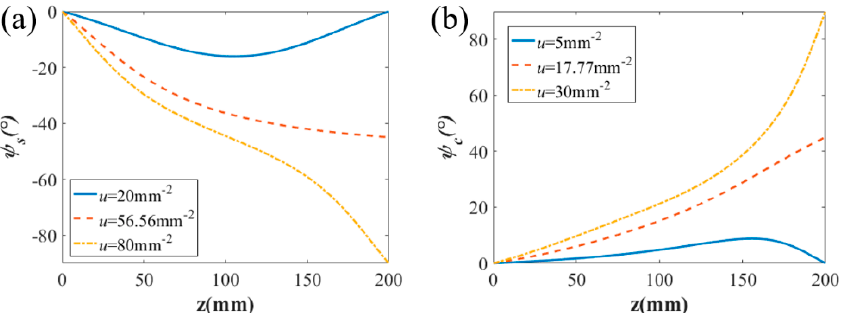
Figure 7. The rotation angle of ( a ) spectral density and ( b ) DOC of rotating anisotropic Gaussian Schell-model (RAGSM) beams with different u .